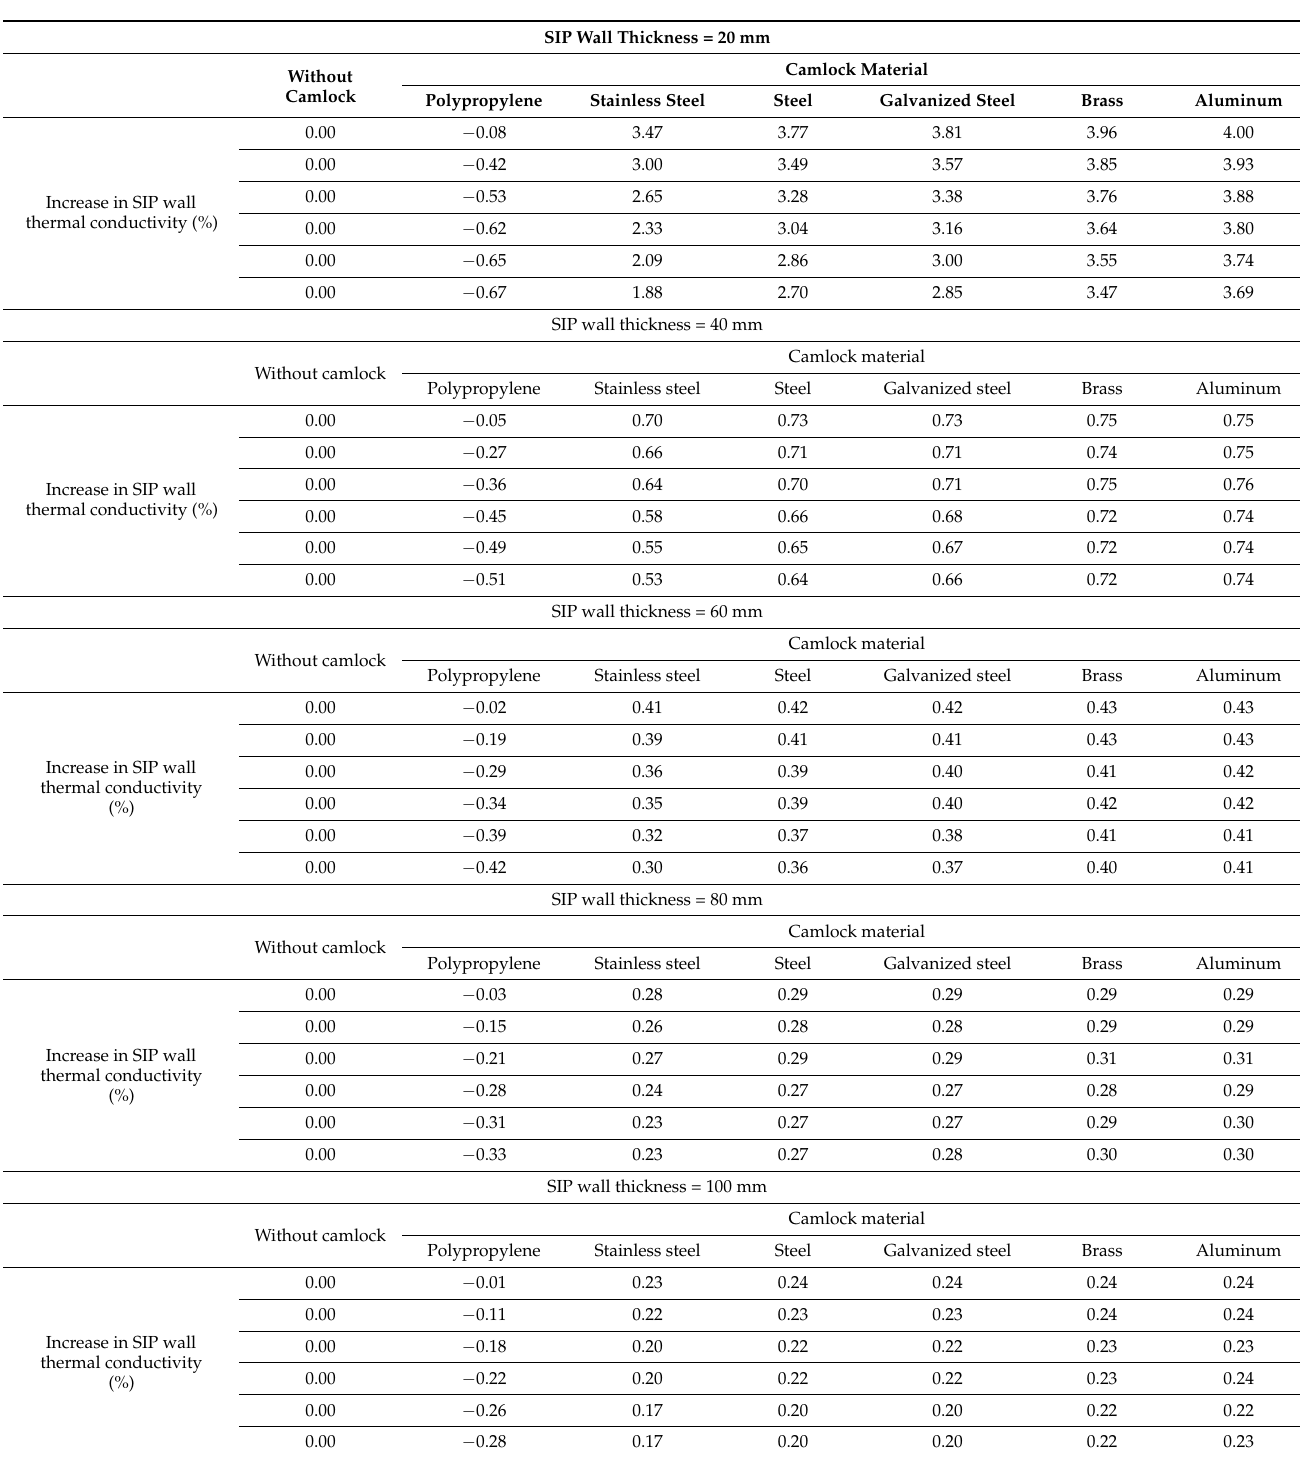
Table 4. Percentage change in the thermal conductivity of the SIP wall with different camlock materials, SIP thermal conductivities, and wall